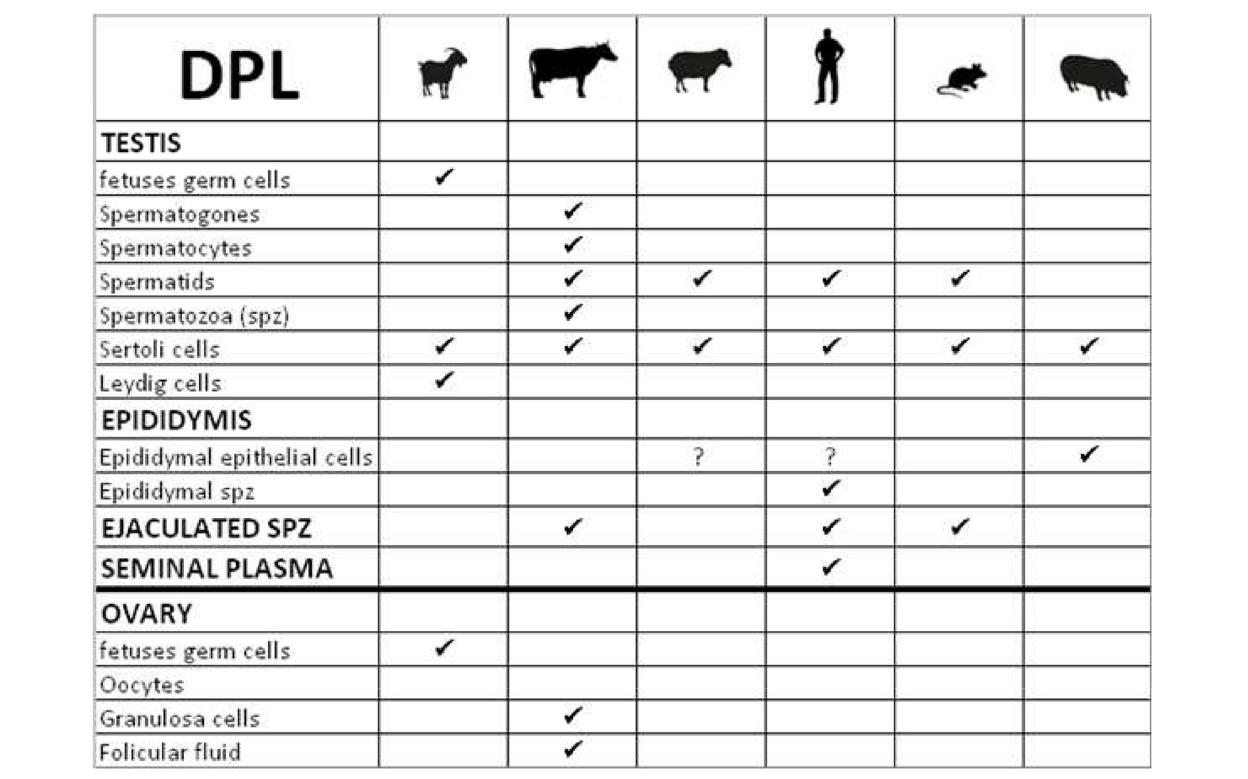
(Shaked et al., 1999) but the nature of PRP c isoforms on sper- matozoa is debated and appears different according to